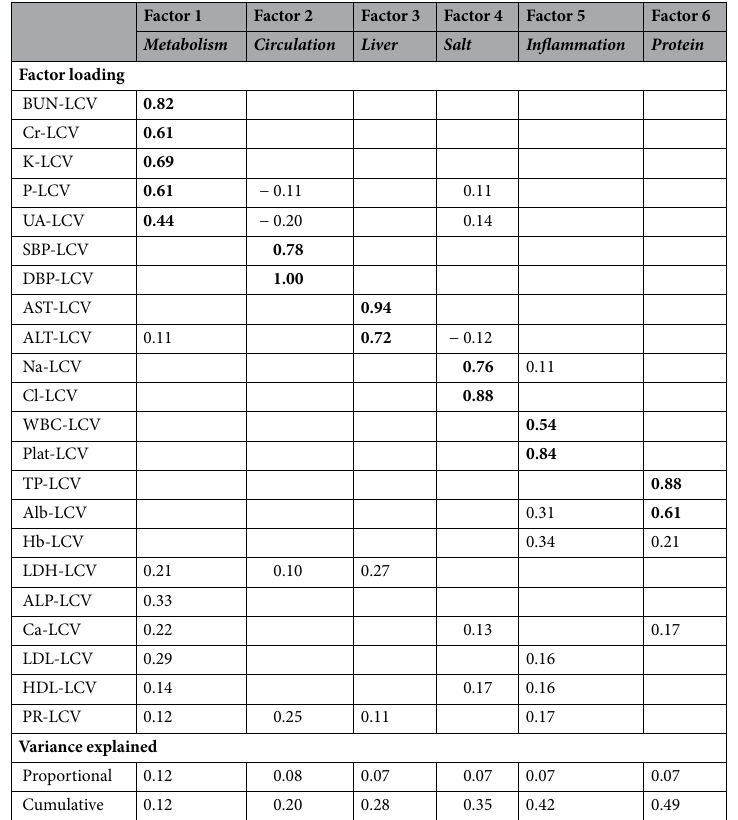
(Table 3). Regarding blood biomarkers, lower levels of Alb, BUN, Cr, Na, LDL and higher levels of AST and ALP are associated with dysregulation in most of the domains, while BMI and SBP levels show positive and